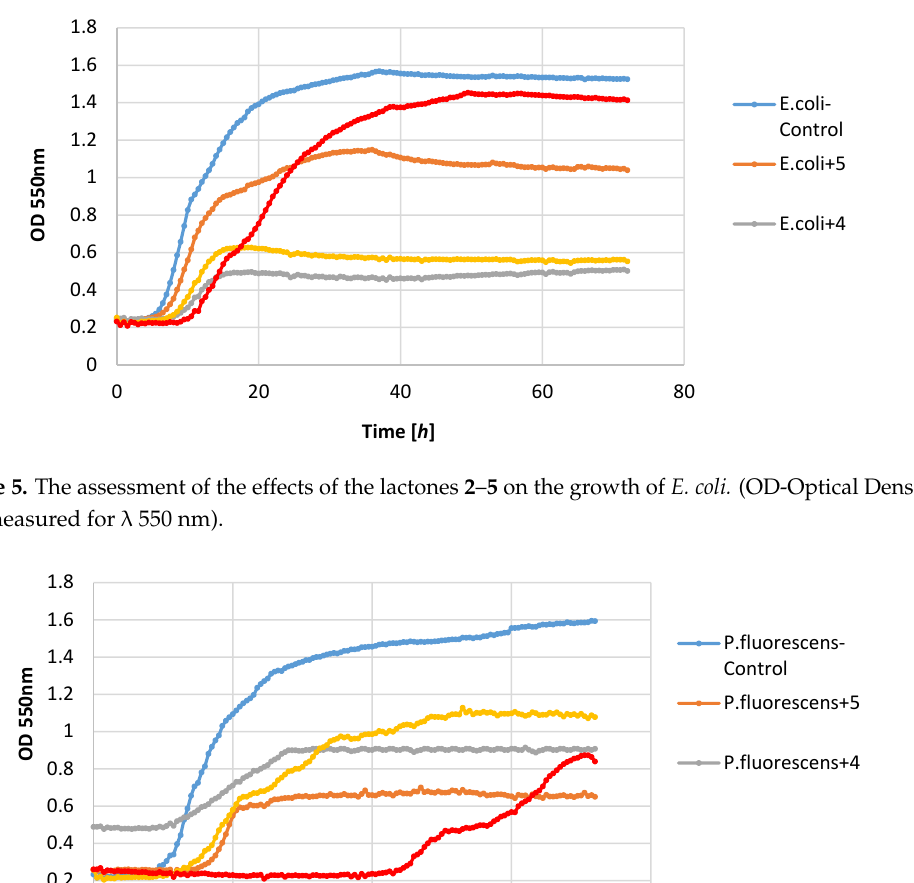
Figure 4. The assessment of the effects of the lactones 2 – 5 on the growth of A.niger. (OD ‐ Optical Density was measured for λ 550 nm).